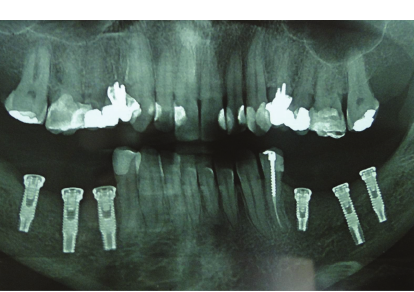
Figure 16: Implants were installed.